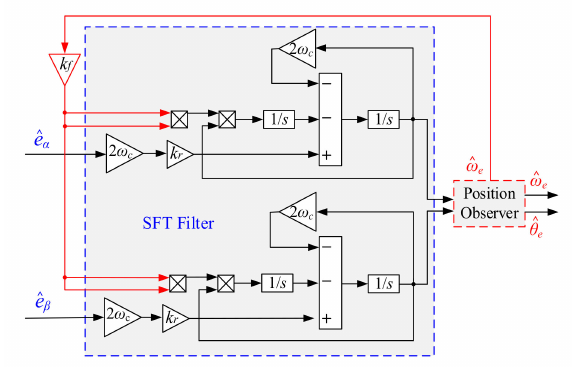
Figure 4. Schematic diagram of the SFT filter.